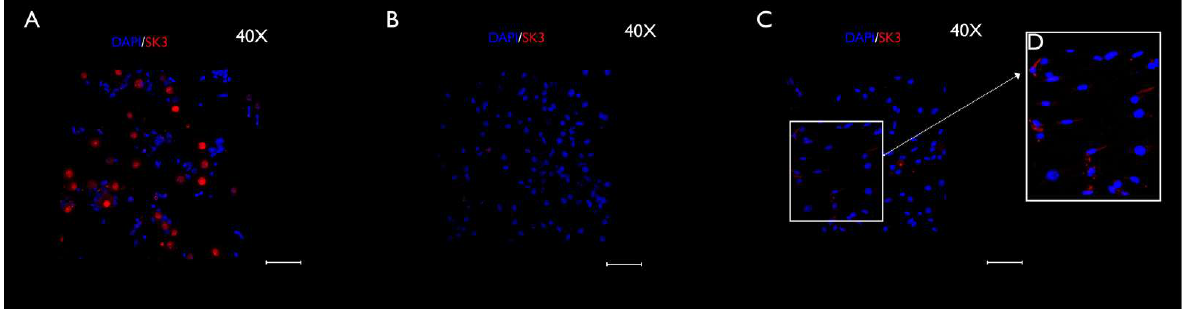
Figure 9. Anti-SK3 immunocytochemistry carried out in cultured TGCs (40× magnification), after 4